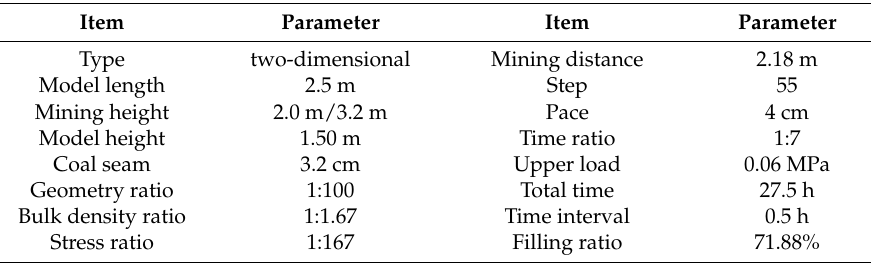
Table 1. Physical model basic